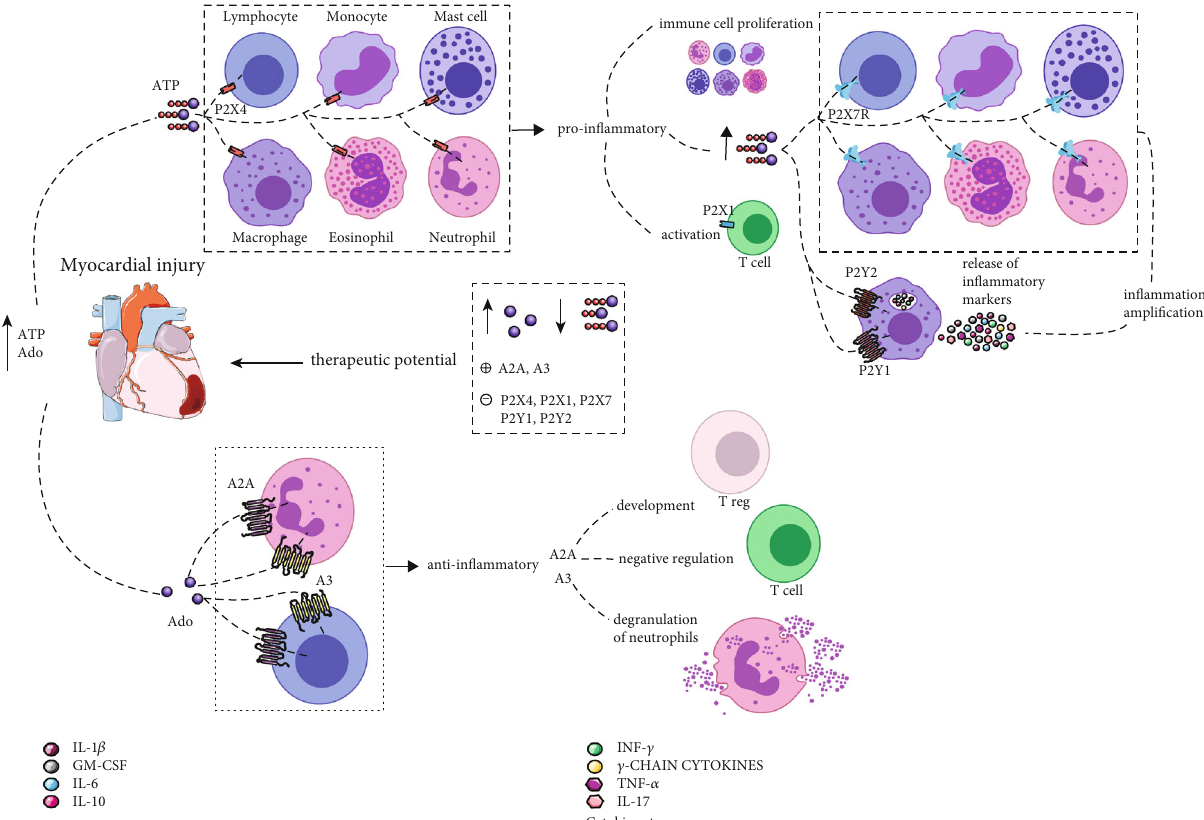
Figure 2: Myocardial injury increases levels of ATP and Ado such that di ff erent purinergic receptors are signalled. Initially, ATP signals P2X4 located on the membrane of immune cells such as mast cells, macrophages, and neutrophils. In response, there is the promotion of the in fl ammatory condition and the increase in ATP, promoting the proliferation of these immune cells, activating T cells by the P2X1 receptor, and signalling the P2X7 receptors of immune cells and the P2Y1 and P2Y2 in macrophages that trigger the release of in fl ammatory markers such as IL-1 β , GM-CSF, IL-6, IL-10, INF- γ , γ -chain cytokines, TNF- α , and IL-17, amplifying in fl ammation. When increases in Ado, A2A and A3, are signalled, the fi rst is responsible for the development of Tregs cells and for the negative regulation of T cells, while A3 is responsible for the degranulation of neutrophils. Thus, as a therapeutic potential for improving myocardial injury, deeper reductions in Ado and ATP occur, as well as positive modulation of A2A and A3 and negative modulation of P2X4, P2X1, P2X7, P2Y1, and